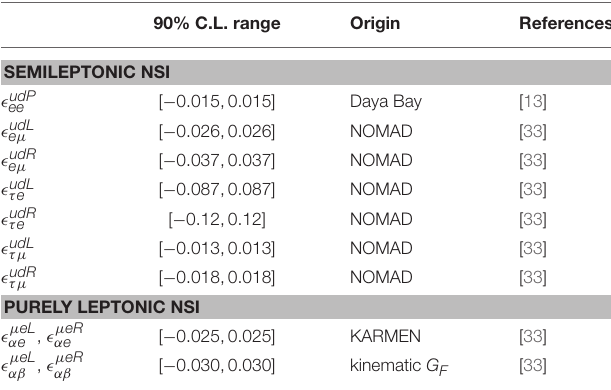
TABLE 4 | Bounds on CC NSI